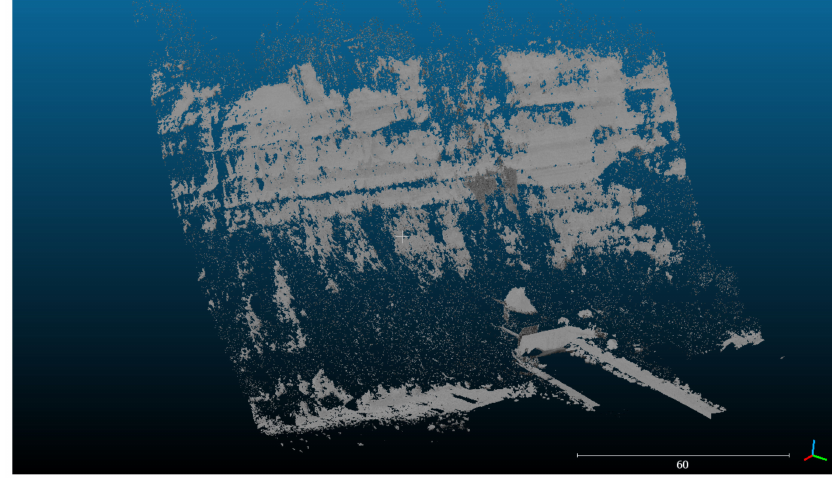
Figure 7. Filtered rock surface after removal of the vegetation